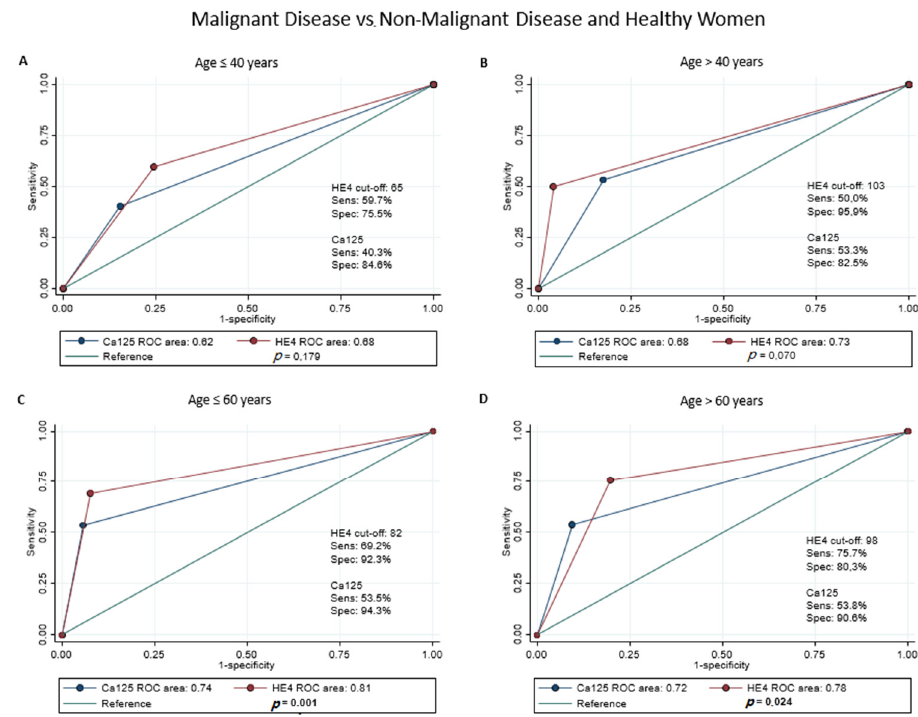
Figure 1. ROC regression analysis of HE4 and Ca125 values in malignant disease vs. non-malignant disease and healthy Women. Population has been stratified as follows: Premenopausal status: ≤ 40 years ( A ), >40 years ( B ); postmenopausal status: ≤ 60 years ( C ) and >60 years ( D ).